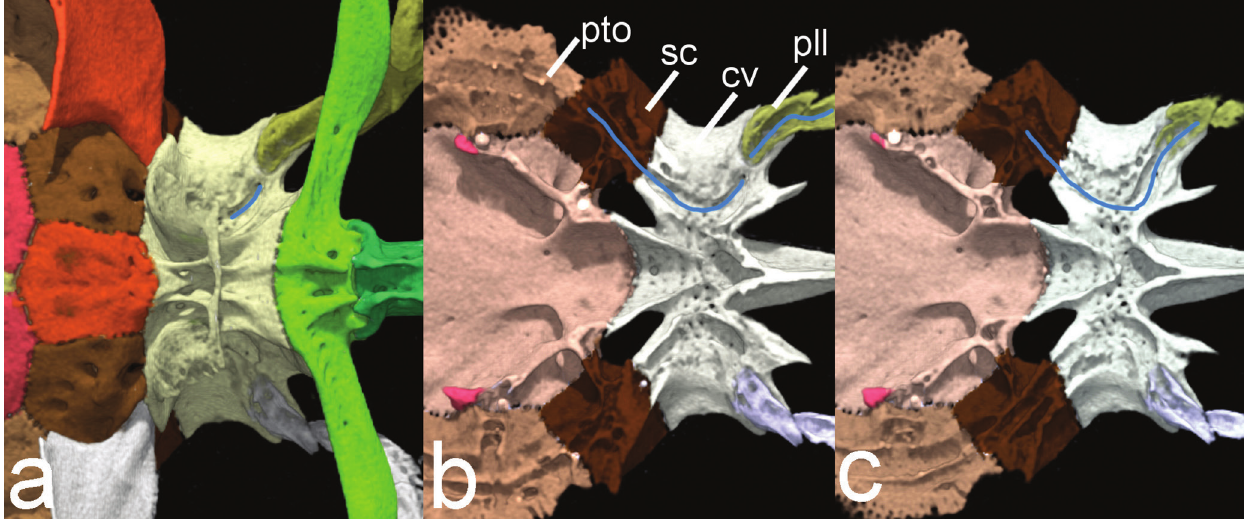
Fig. 11. Sequential cut of complex vertebrae of Weberian apparatus and elements associated with posterior lateral line in ventral view of Hoplomyzon cardosoi , MCNG 375, holotype, 18.5 mm SL. a. Ventral view, b. cut at horizontal line at about dorsal limit of vertebra 5, and c. cut at horizontal line at about dorsal limit of second posterior lateral line tubule. Left side of posterior lateral line canal pathway highlighted in blue. cv: complex vertebrae; pll: posterior lateral line tubule; pto: pterotic; sc: